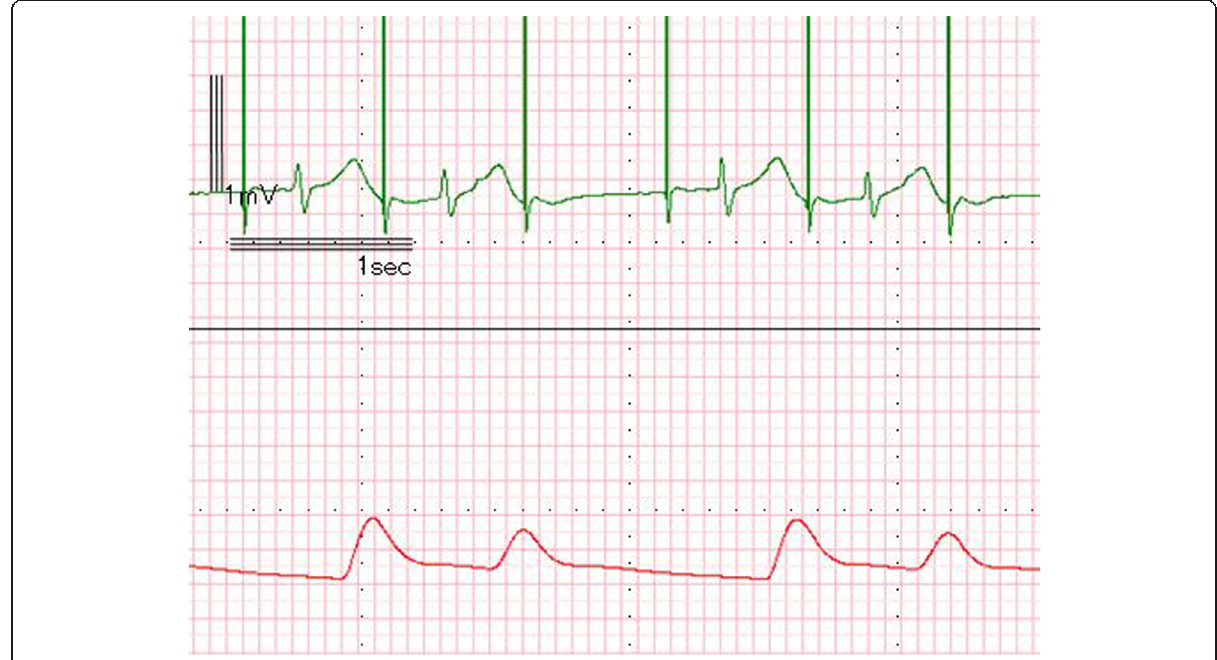
Fig. 2 ECG and pressure waveform showing Mobitz type AV block. Each AOO pacing spike captures a P wave, but every third P wave does not induce a QRS wave